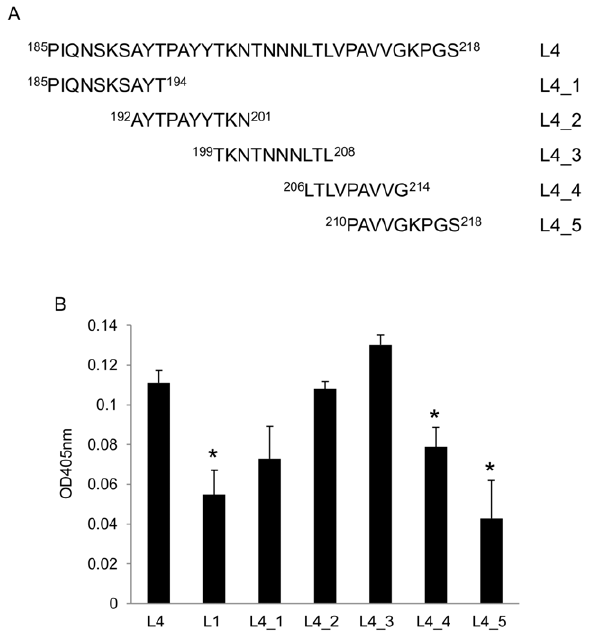
Figure 4. LamR binding activity of PorA loop 4 peptides. (A) Schematic showing the sequence of the overlapping loop 4 peptides (L4_1 to L4_5) and alignment to the MC58 PorA loop 4 sequence (L4). (B) ELISA data showing the binding of LamR to immobilized loop 1 and loop 4 synthetic peptides. Data shown are means from at least three independent experiments; in each experiment each sample was tested in triplicate. * p , 0.05 compared to binding of LamR to whole loop 4 (L4). Error bars indicate